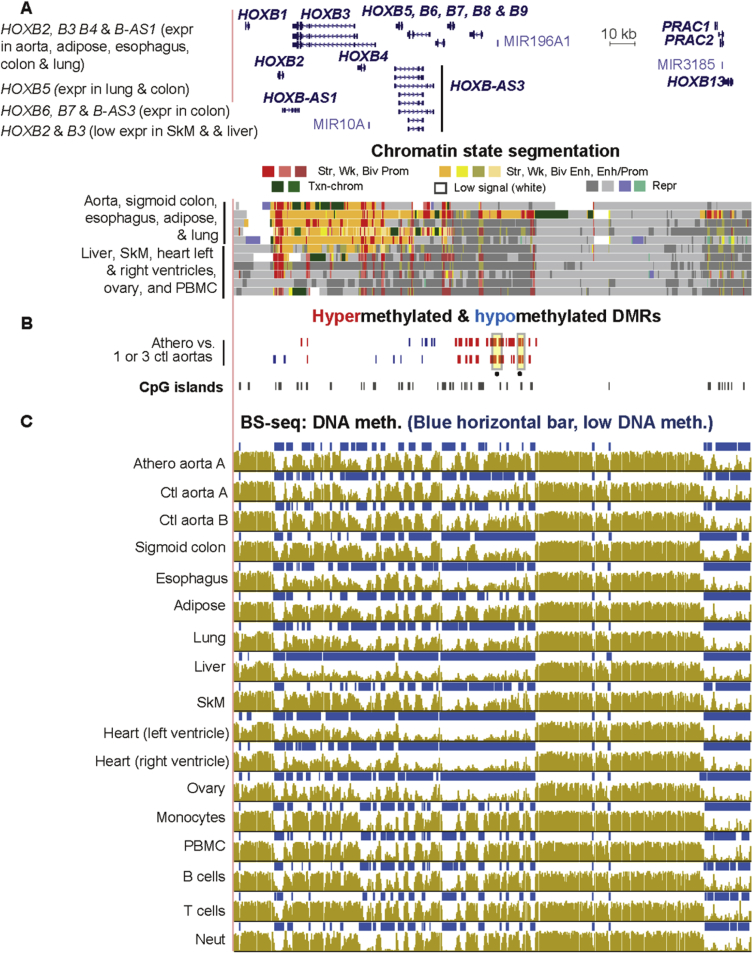
The HOXB gene cluster displays a subregion exhibiting atherosclerosis-associated DNA hypermethylation and another with mostly athero hypomethylation. RefSeq gene isoforms (chr17:46,602,205-46,813,770) with chromatin state segmentation, DMRs and bisulfite-seq as in previous figures.